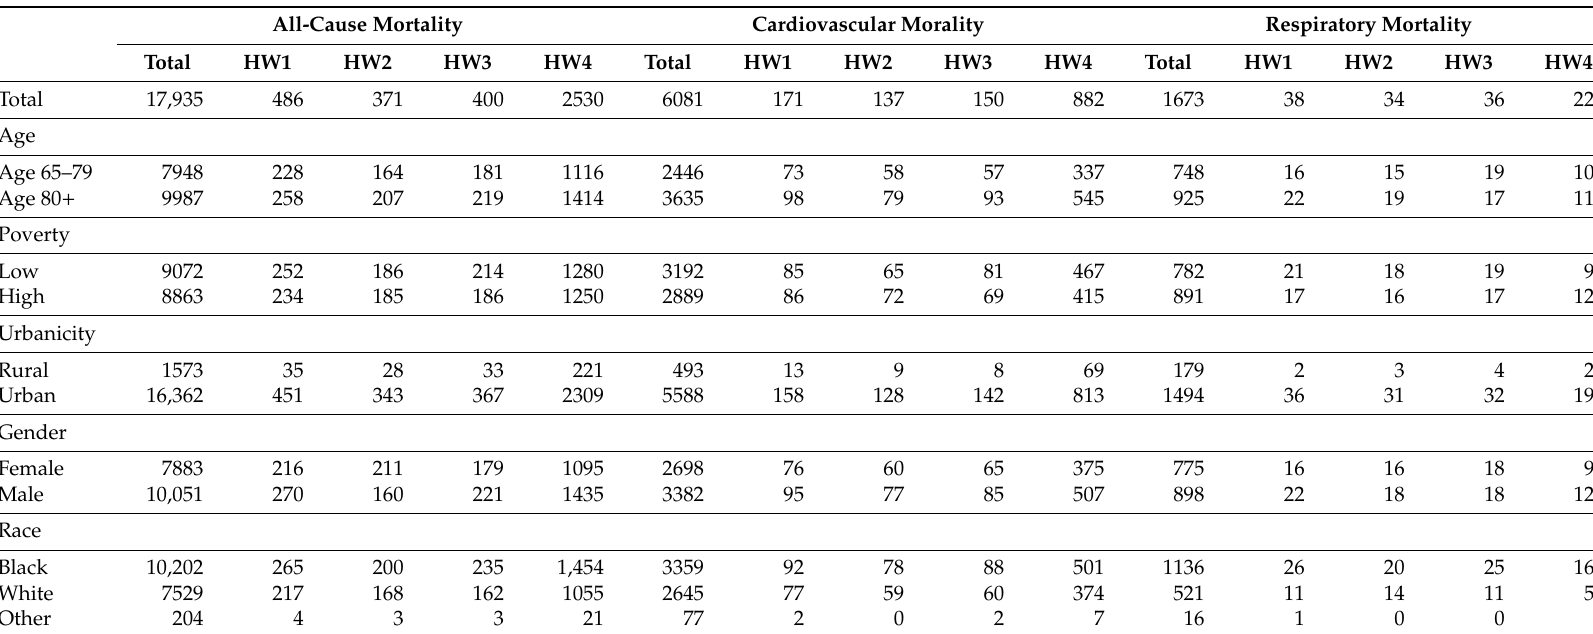
Table 3. Death numbers in May–September and heatwave days due to all causes, cardiovascular diseases, and respiratory diseases in Shelby County in 2008–2017. All-Cause Mortality Cardiovascular Morality Respiratory